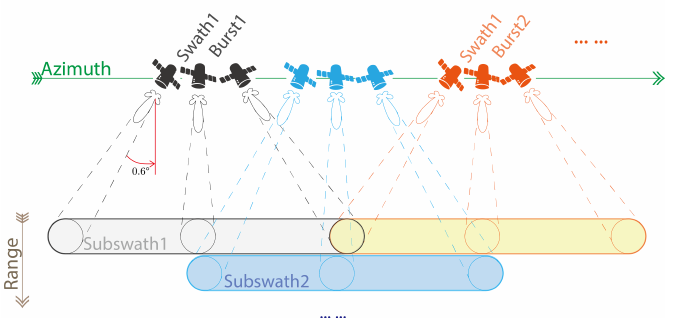
Figure 1. An illustration of TOPS working